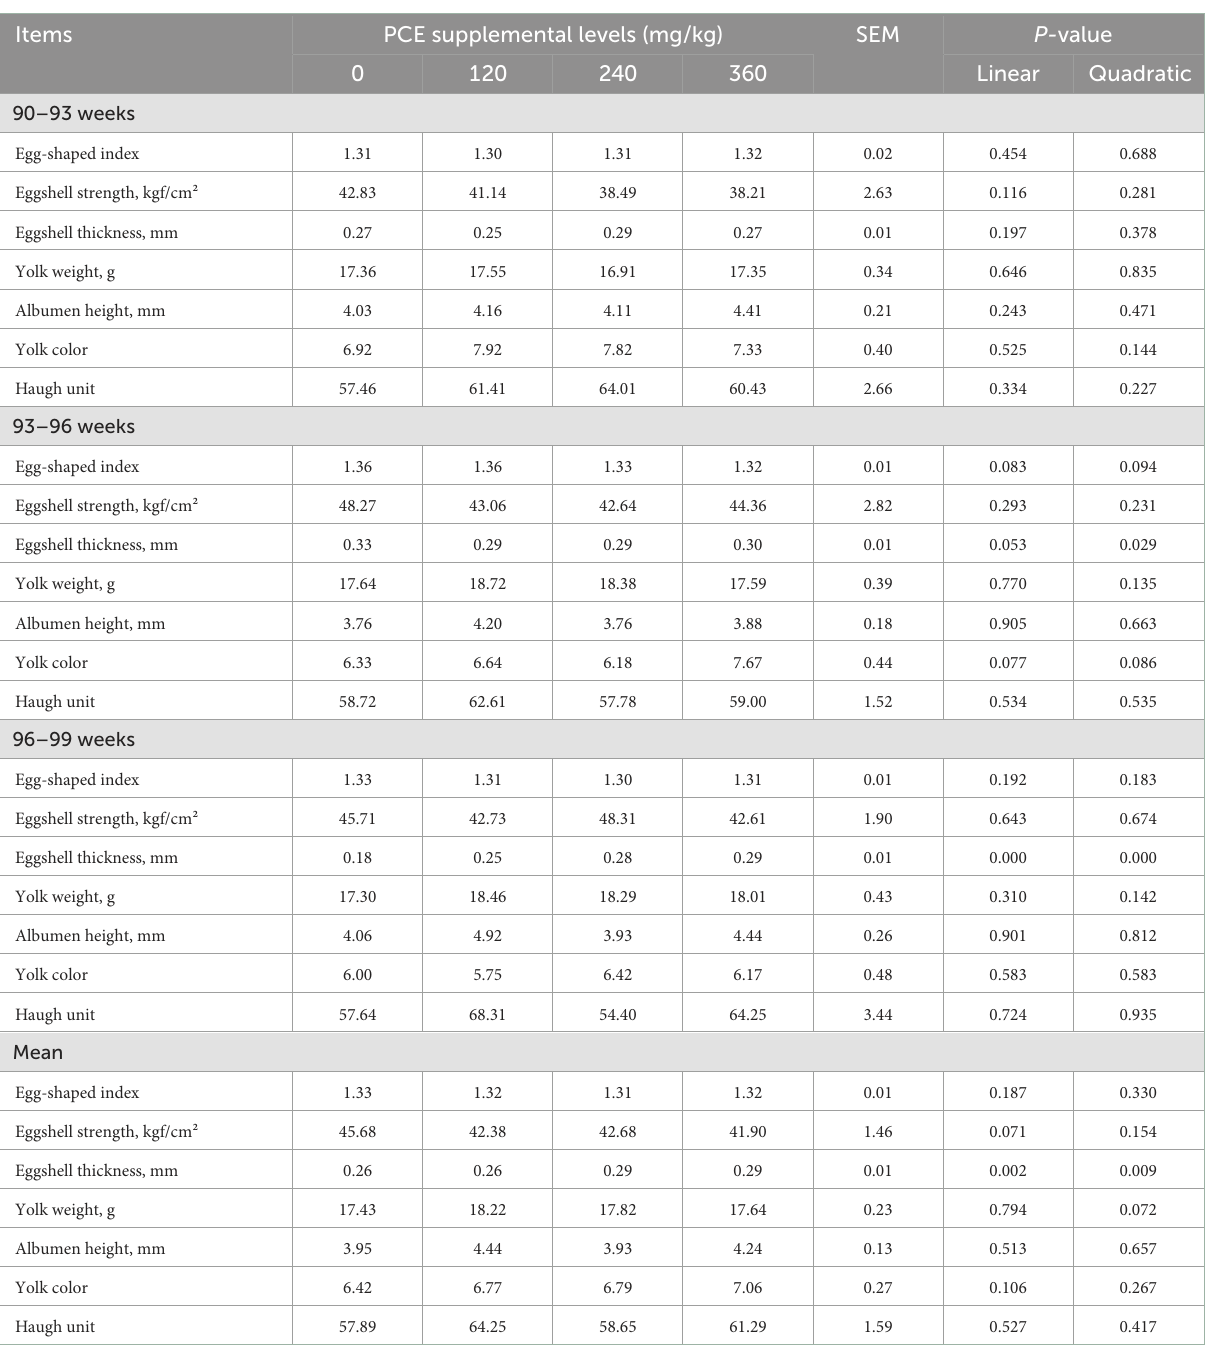
TABLE 4 Effect of purple corn extract on egg quality in laying